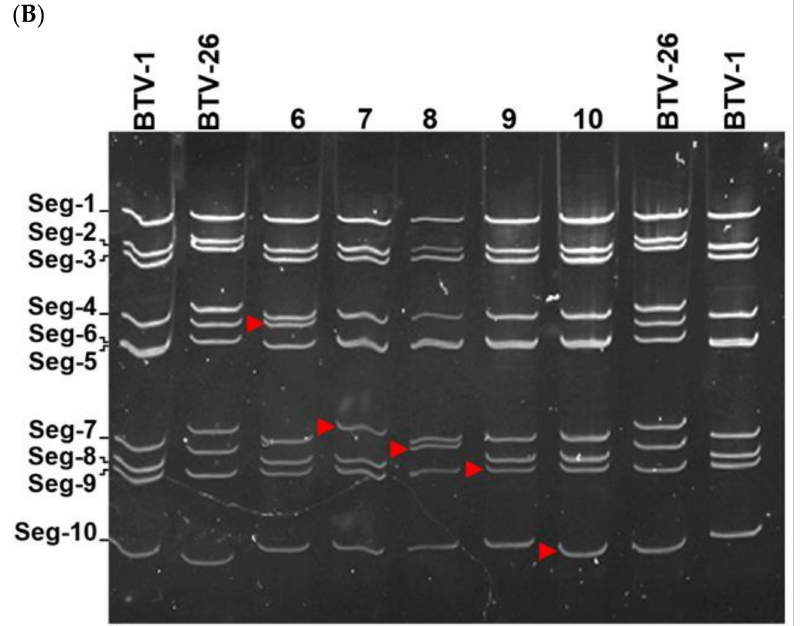
Figure 4. Analysis of the electropherotypes of the 10 reassortants of BTV-26 in BTV-1 backbone in 7.5% polyacrylamide gel. Segments derived from BTV-26 are indicated by a red arrow. ( A ) shows the electropherotypes of BTV-1RG C7 and BTV-26, as well as RGBTV1:1 (26) in lane 1, RGBTV1:2,6,7 (26) in lane 2RGBTV1:3 (26) in lane 3, RGBTV1:4 (26) in lane 4 and RGBTV1:5 (26) in lane 5. ( B ) shows the electropherotypes of BTV-1RG C7 and BTV-26, as well as : RGBTV1:6 (26) in lane 6, RGBTV1:7 (26) in lane 7, RGBTV1:8 (26) in lane 8, RGBTV1:9 (26) in lane 9 and RGBTV1:10 (26) in lane